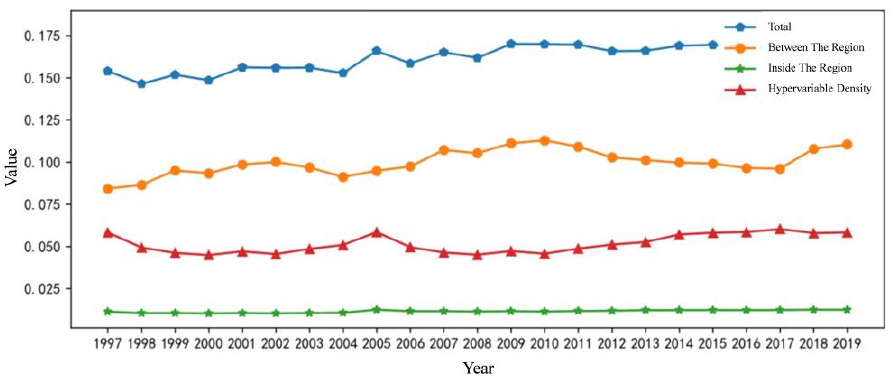
Figure 2. National Dagum Gini coefficient change trend chart.